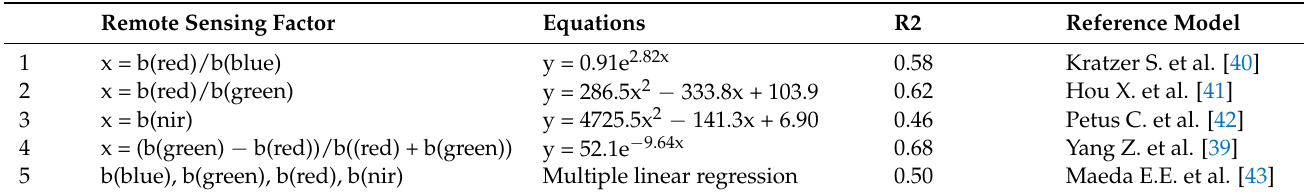
Figure 5. Regression analysis of pseudo-invariant feature points. ( a ) blue band, ( b ) green band, ( c ) red band, ( d ) nir band. Table 2. Inversion algorithm of different